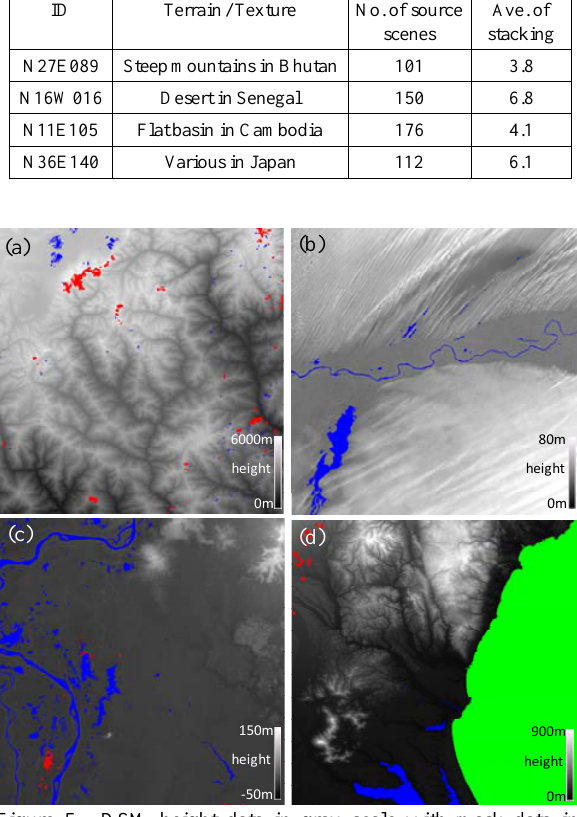
Figure 5. DSM height data in gray scale with mask data in colours: (a)N27E089, (b)N16W016,(c) N11E105, (d)N36E140. The red, blue, and green in the images indicate cloud/snow, inland-water, and sea masks respectively.